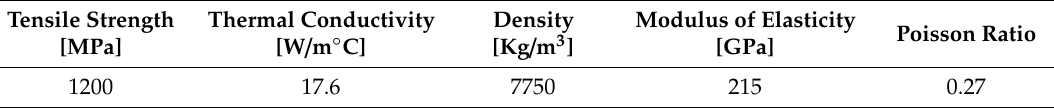
Table 2. Mechanical properties of the hot work tool steel (AISI H13).